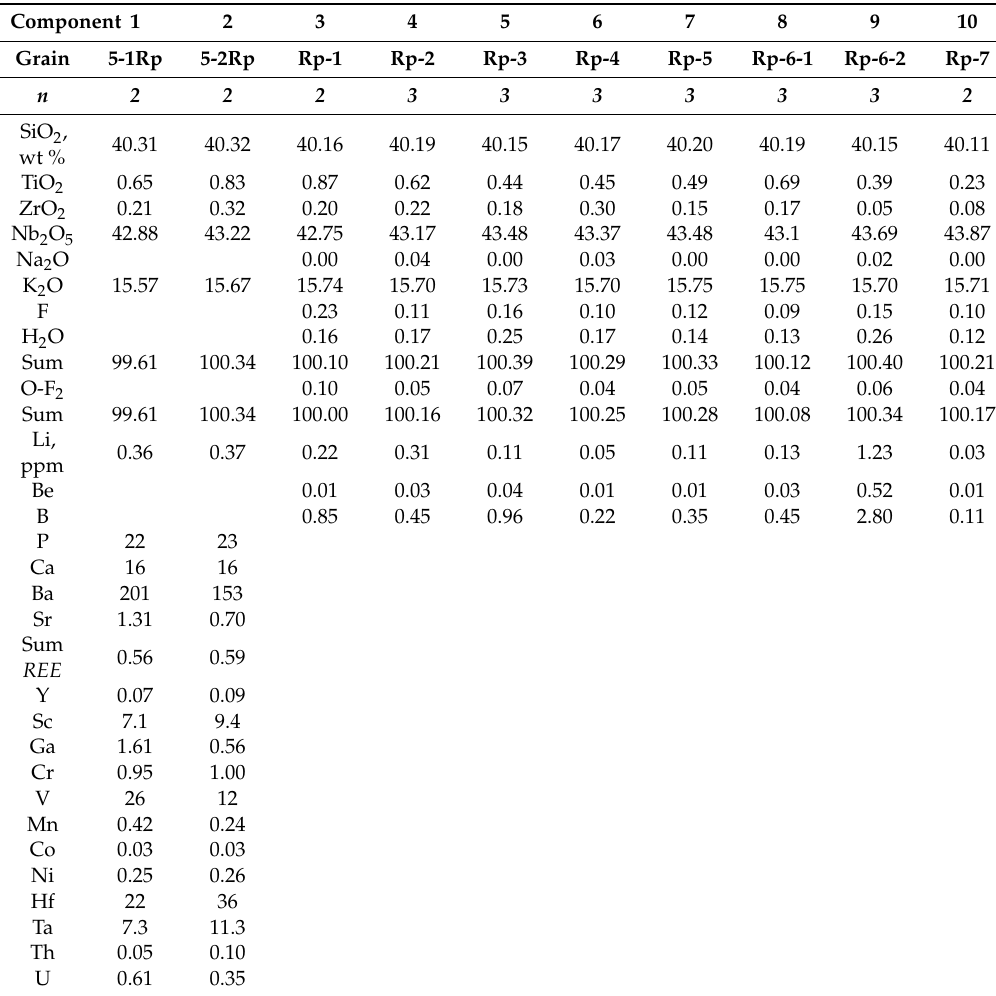
Table 4. Major and trace element composition of individual grains of rippite from the Chuktukon calciocarbonatite (holotype sample 546-193.5), Chadobets upland, Siberia, Russia. Component